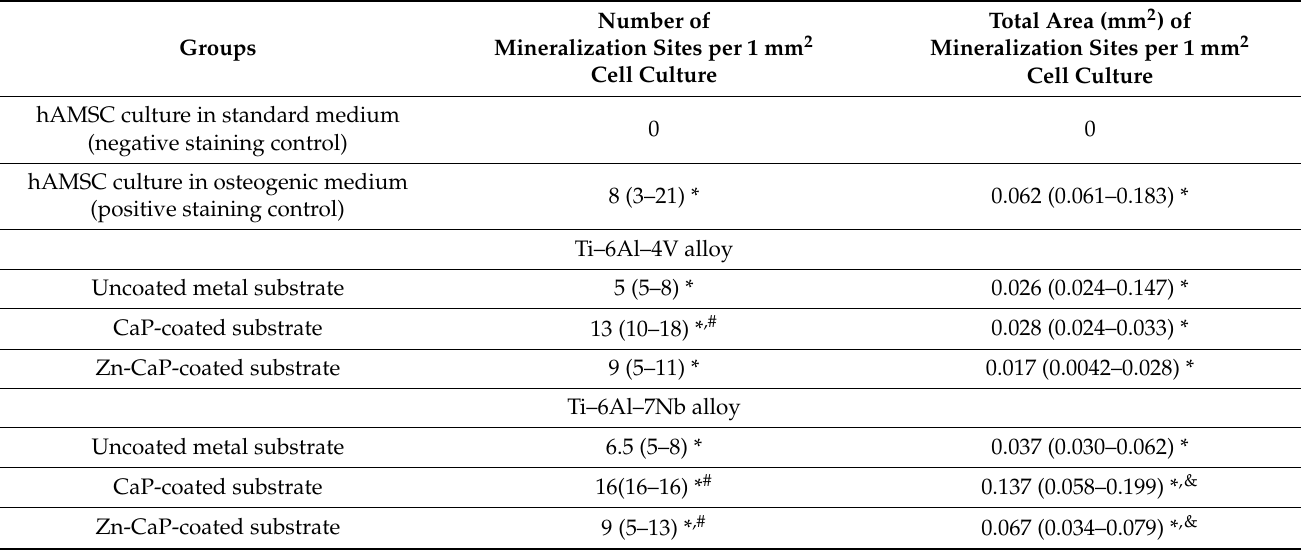
Table 5. In vitro effect of test samples on hAMSC osteogenic differentiation with mineralization of cell culture matrix after